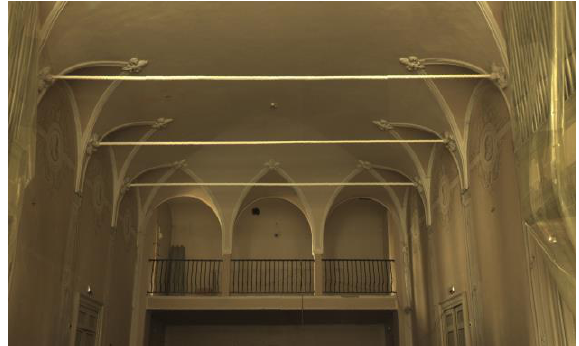
Figure 2. The nailed and lowered profile pavilion vault which covers the Sala Verdi of Conservatorium, in Parma (Italy) Largeness and disposition of passing and non-passing cracks, variously distributed on the main longitudinal walls of the pavilion and on the vault itself, have been analysed, coupled with the survey of the degradation of materials.